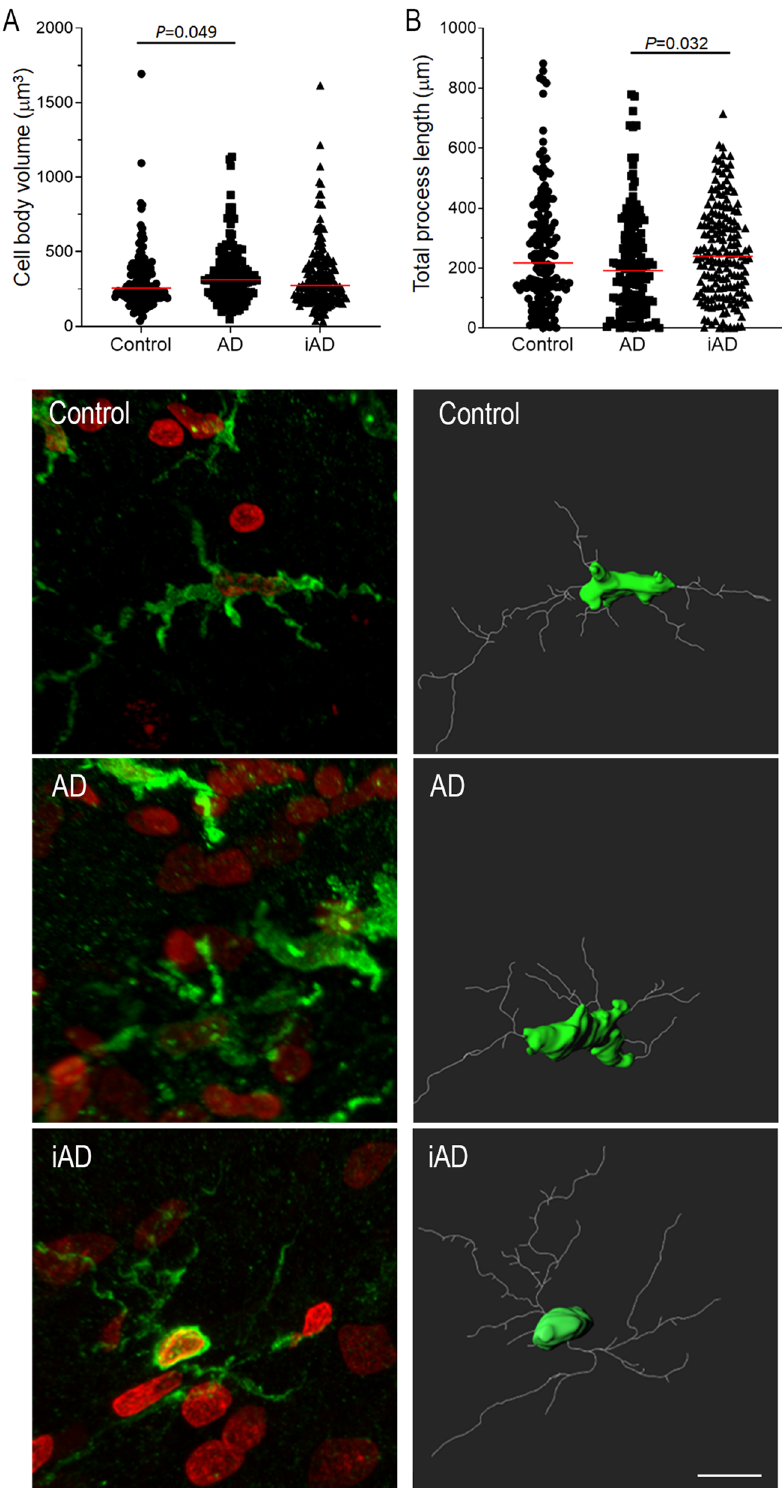
Figure 2. Quantification and illustration of the microglial morphological features after a 3D-reconstruction. ( A ) cell body volume increased in AD (n = 10) compared to controls (n = 10), and ( B ) total process length increased in iAD (n = 15) compared to AD (n = 10). Illustration of microglial cells representative of the median cell body volume and total length for each group. Total n = 35 cases. Left column: maximum intensity projection of the confocal Z-stacks (green—microglial marker Iba1; red—cell nuclei identified with the fluorescent DNA stain DAPI). Right column: 3D-reconstructed models of selected microglia, showing AD with larger body volume than control, and iAD with more extended total process length than AD. Brain area: inferior parietal lobule. Scale bar = 10